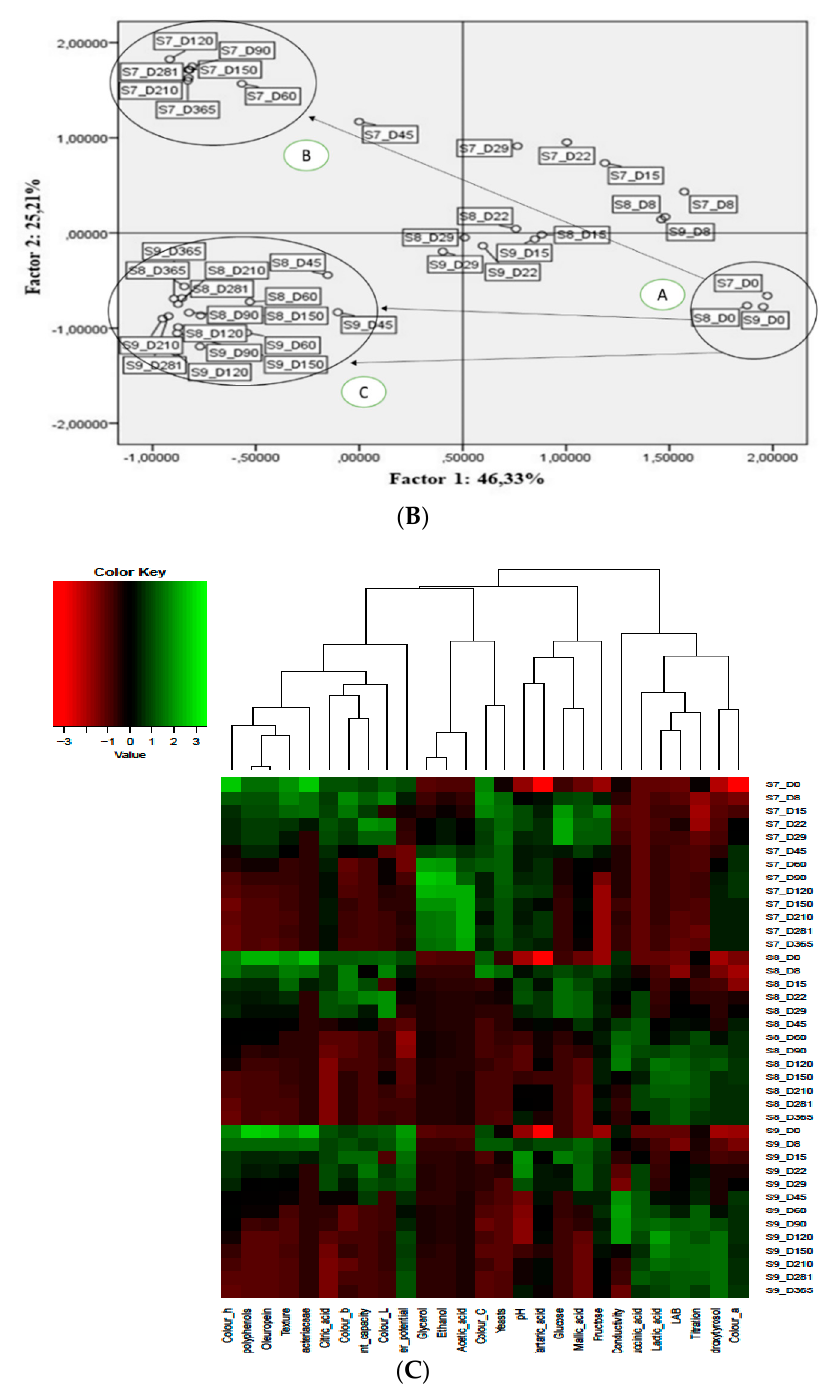
Figure 9. ( A ) PermutMatrixEN analysis between microbial and physicochemical profiles of spontaneous, inoculated (10% NaCl), and inoculated (7% NaCl) fermentation of Cypriot green cracked table olives. ( B ) The plot of scores and loadings between treatments formed by the first two principal components from the PCA (principal component analysis) analysis. Labeling of data points indicates the processing treatment of olives (S9: inoculated and 7% NaCl concentration, S8: inoculated and 10% NaCl concentration, S7: control) and fermentation time (D: Days). ( C ) Heatmap showing the similarities in the observed microbial and physicochemical profiles between the three experiments during fermentation days. Labeling of data points indicates the processing treatment of olives (S9: inoculated and 7% NaCl concentration, S8: inoculated and 10% NaCl concentration, S7: control) and fermentation time (D: Days).